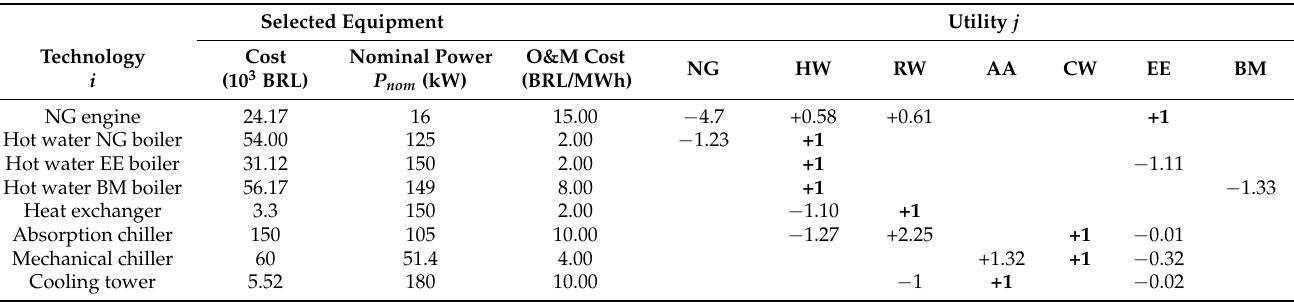
Table 2. Matrix of technical production coefficients.